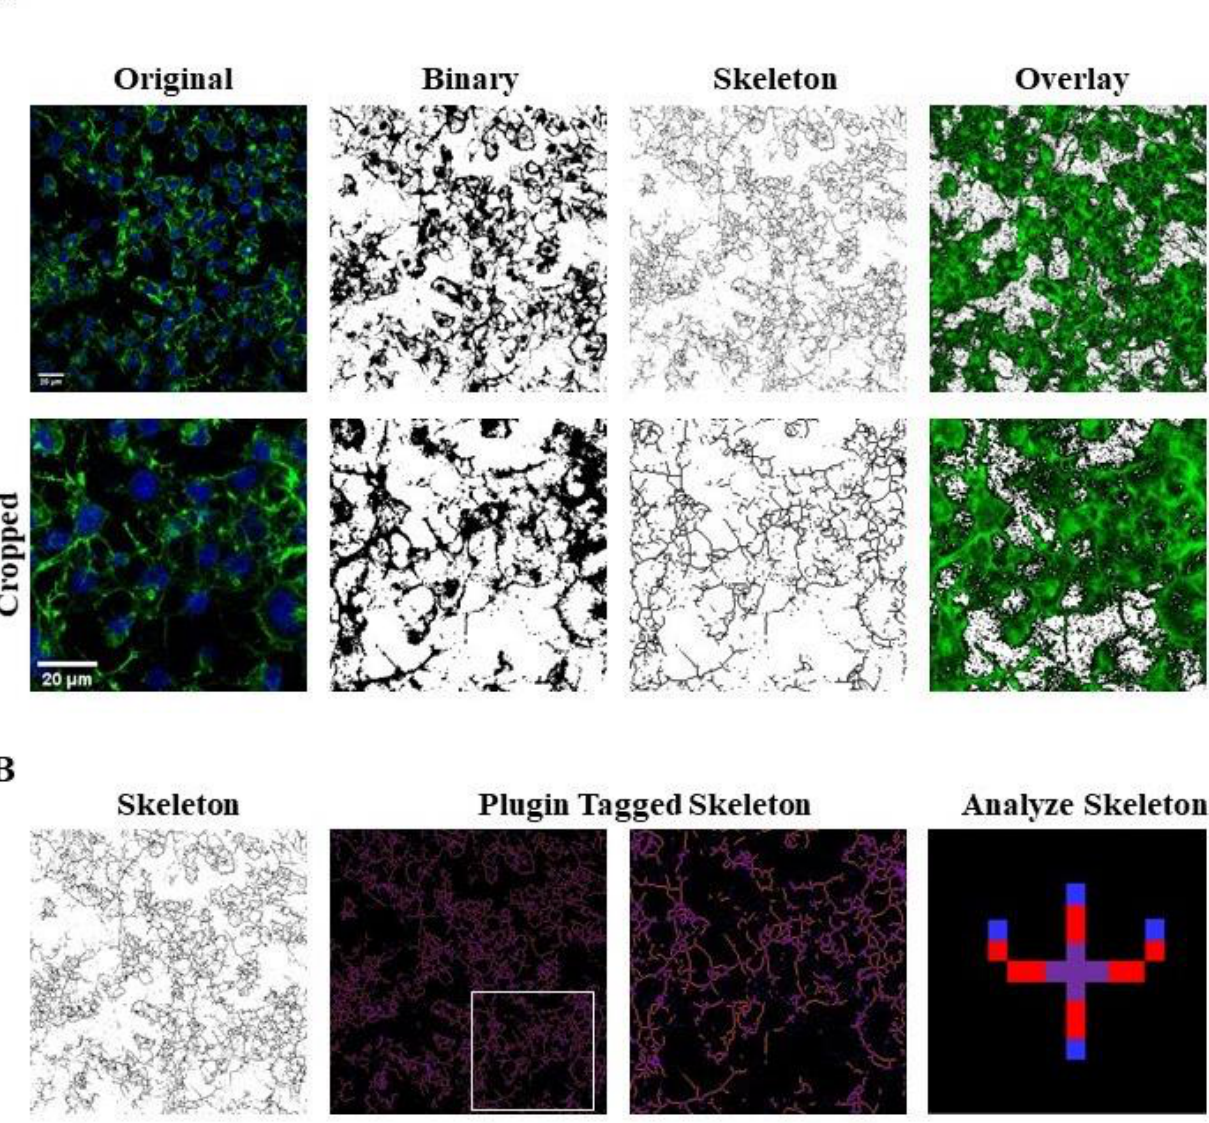
Figure 12. Skeleton Analysis application to quantify Neuro-2A cells morphology. ( A ) Representative photomicrograph (40 × magnification) and the series of ImageJ plugin protocols which were applied to each photomicrograph for skeleton analysis. Original photomicrograph was modified enhancing the background, removing noise and using with FFT filter prior to be converted to binary images. Binary image was skeletonized. The overlay of skeletonized and original images is reported; cropped photomicrographs show the image details. Scale bar: 20 µ m. ( B ) The workflow used to Analyze Skeleton plugin: skeletonized process in orange, endpoint in blue, and junction in